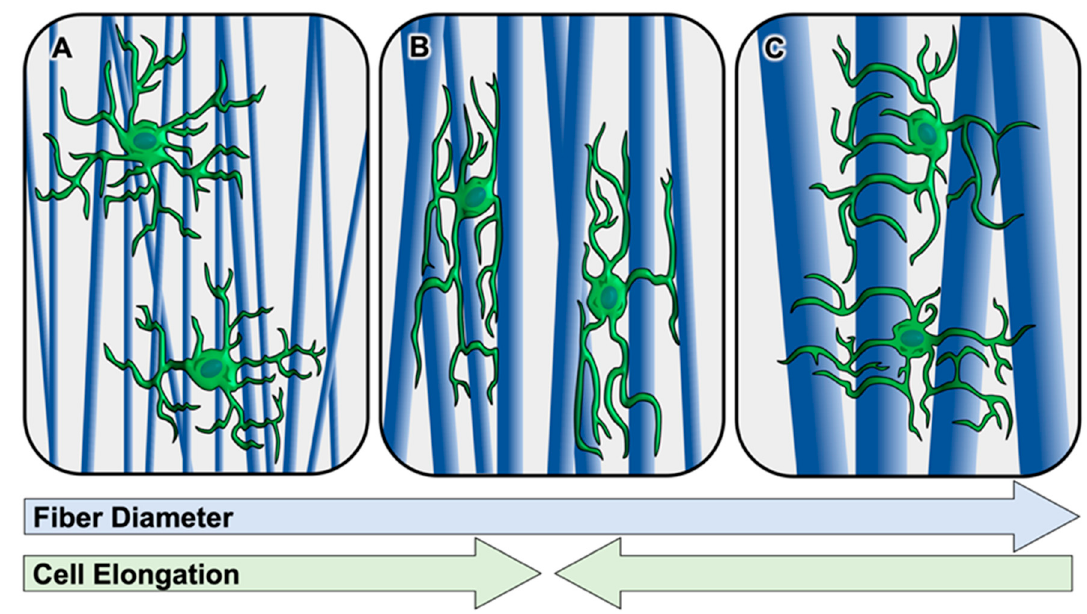
Figure 3. Effect of aligned fiber diameter on glial cell elongation. ( A ) Glial cells spread radially on small diameter fibers. ( B ) Glial cells elongate along the orientation of the aligned fibers on medium diameter fibers. ( C ) Glial cells spread radially on large diameter fibers.